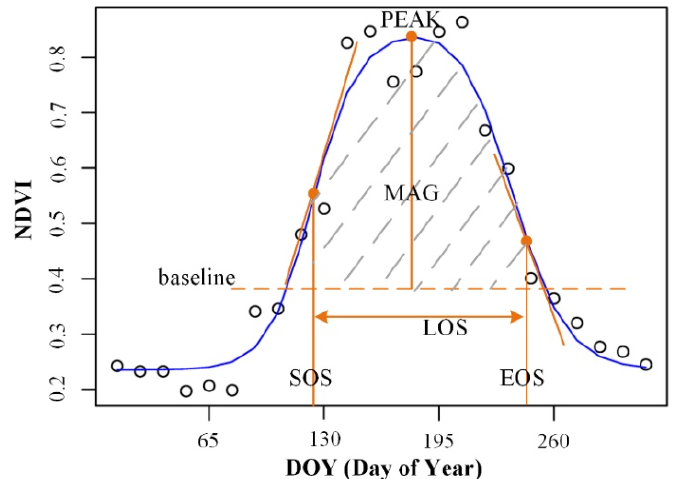
Figure 2. Schematic diagram depicting the growth curve and key phenological parameters. Circles represent remote sensing normalized di ff erence vegetation index (NDVI), the blue line is fitting growth curve, the oblique orange lines denote tangent lines at SOS, EOS; SOS: Start of growing season, EOS: End of growing season, LOS: Length of growing season, MAG: PEAK minus Baseline Value